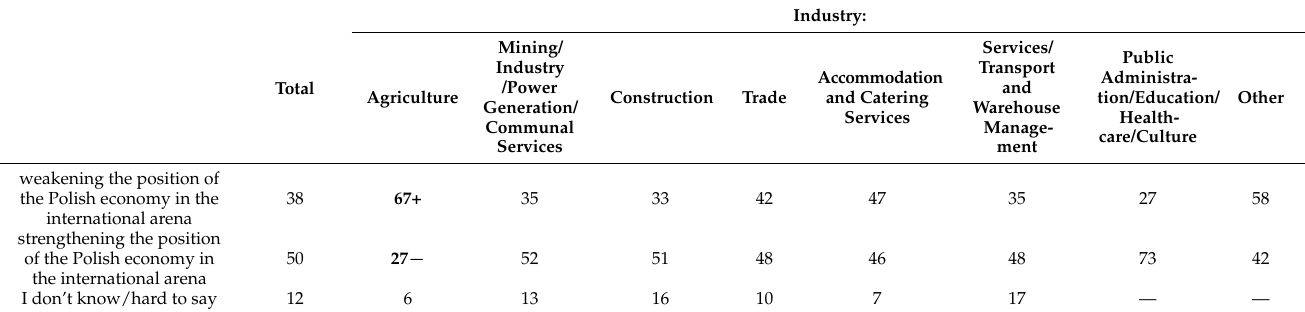
Table 6. Can ecologists’ demands, such as those concerning the necessity to reduce CO 2 , contribute to . . . in Poland? (in percent- age